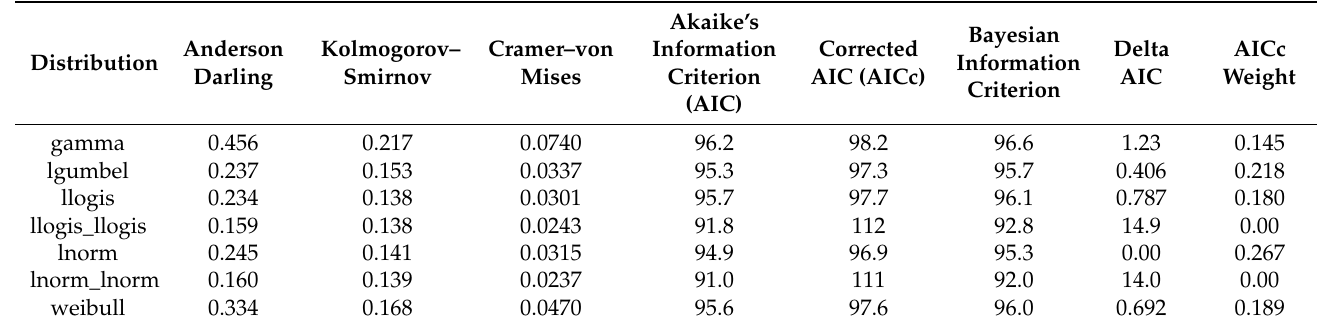
Table 5. Model-fit statistics used to estimate the fifth percentile of the hazard concentrations derived from the species sensitivity distribution based on the acute toxicity of PC shown in Figure